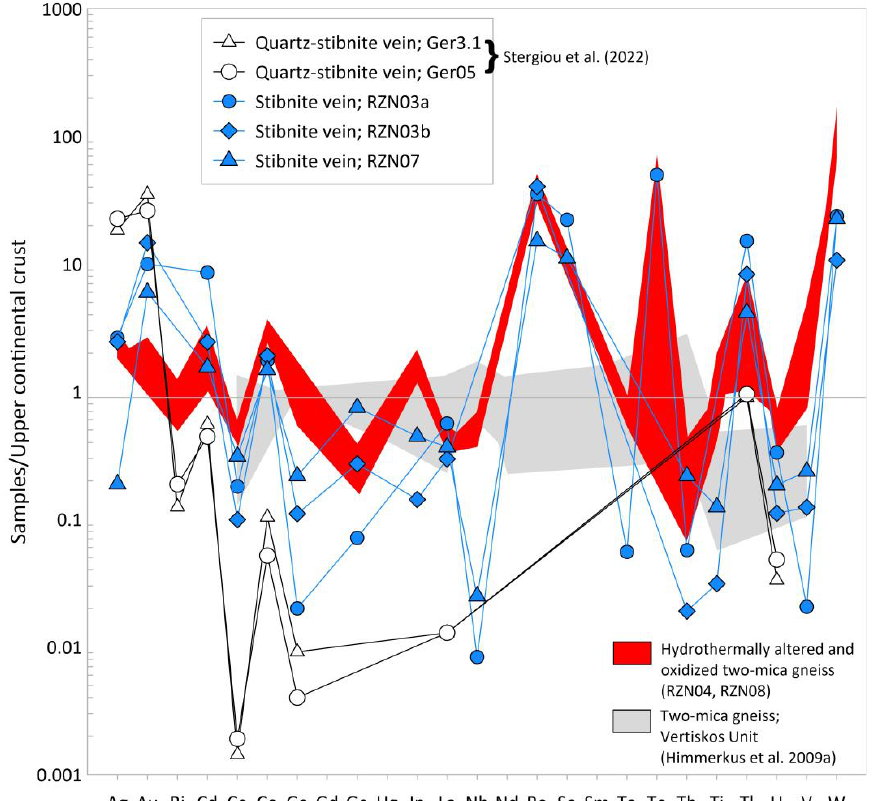
Figure 12. Upper continental crust normalized logarithmic spider diagram of selected critical metals from the three stibnite vein samples analyzed in this study compared to the stibnite mineralization from Gerakario (after Stergiou et al. [8]) and to the plot area of the analyzed two-mica gneiss (red shaded). The plot area (gray shaded) of the reference two-mica gneiss from the Vertiskos Unit published by Himmerkus et al. [36] is also shown for comparison (Upper continental crust normalized values after [53]).